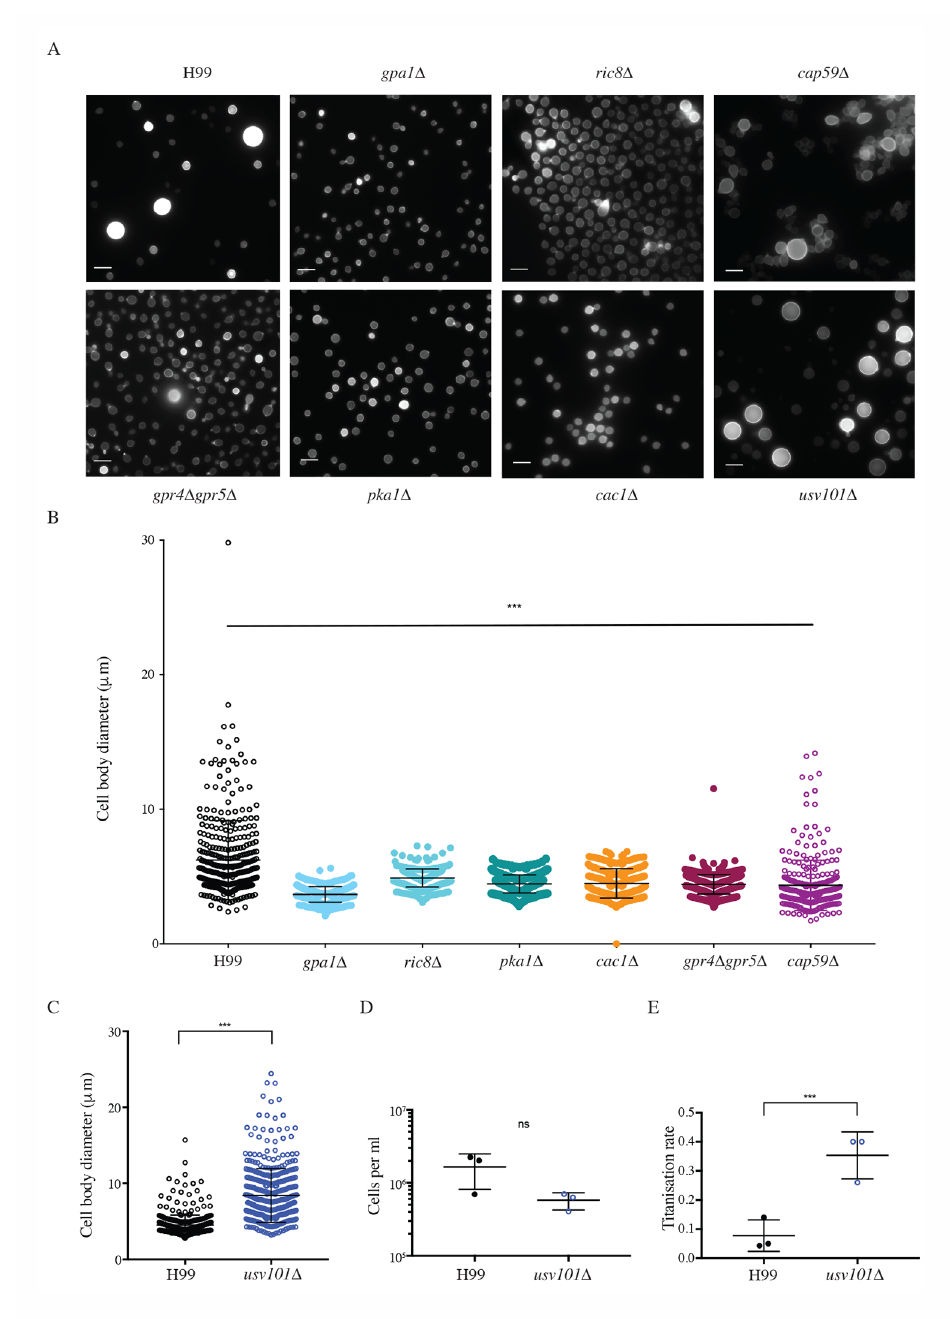
Fig 6. The cAMP/PKA pathway and the Usv101 transcription factor influence in vitro titanisation. A,B) Wild- type, gpa1 Δ , ric8 Δ , gpr4 Δ gpr5 Δ , pka1 Δ , cac1 Δ ,and cap59 Δ cells were incubated under Titan inducing conditions. A) Representative micrographs for fixed cells are shown (CFW). Scale bar = 10 μm. B) Cell size was quantified for the indicated strains. Significance was assessed using Kruskal-Wallis and Dunn’s multiple comparisons (relatively to H99, p < 0.0001 for all strains, n > 300). C) Wild-type and usv101 Δ cells were incubated under the indicated conditions. Representative micrographs for fixed cells are shown (CFW). D) Cell size was quantified for wild type and usv101 Δ cells induced in YNB+10% FCS (p < 0.0001). E,F) H99 and usv101 Δ Titan cells were induced for 24 hrs, enriched for cells > 11μm, normalized to 10 3 cells per ml, then returned to inducing conditions for 48 hr. Total cell populations and cells > 11μm were then counted by haemocytometer as a measure of E) cell proliferation (p = 0.116) and F) Titanisation rate (p = 0.008) (triplicate biological replicates). Significance was assessed using Mann Whitney U in all